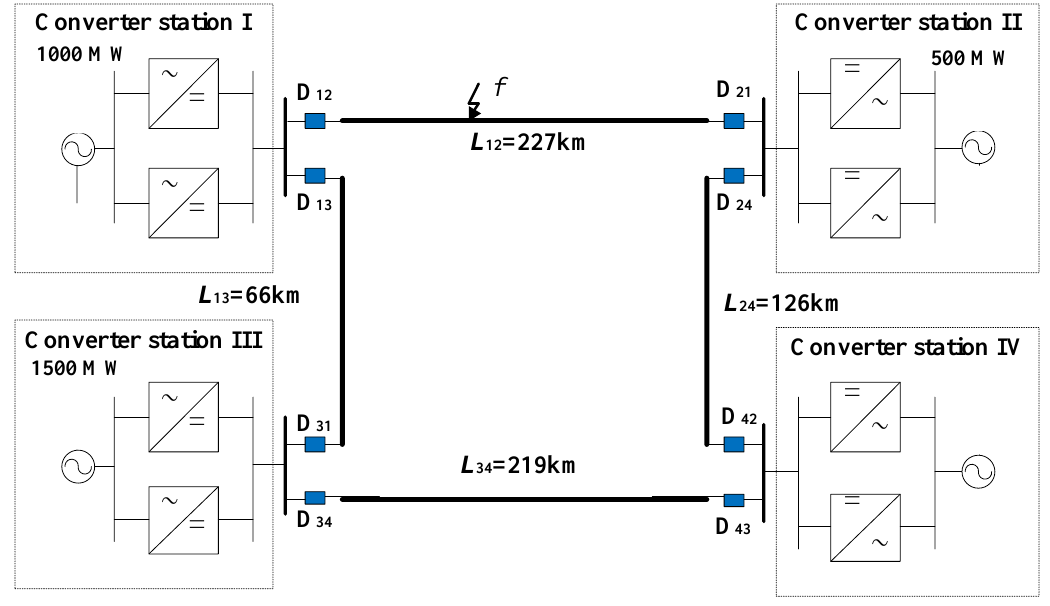
Figure 9. Simulation model for the Zhangbei MMC-HVDC power grid.